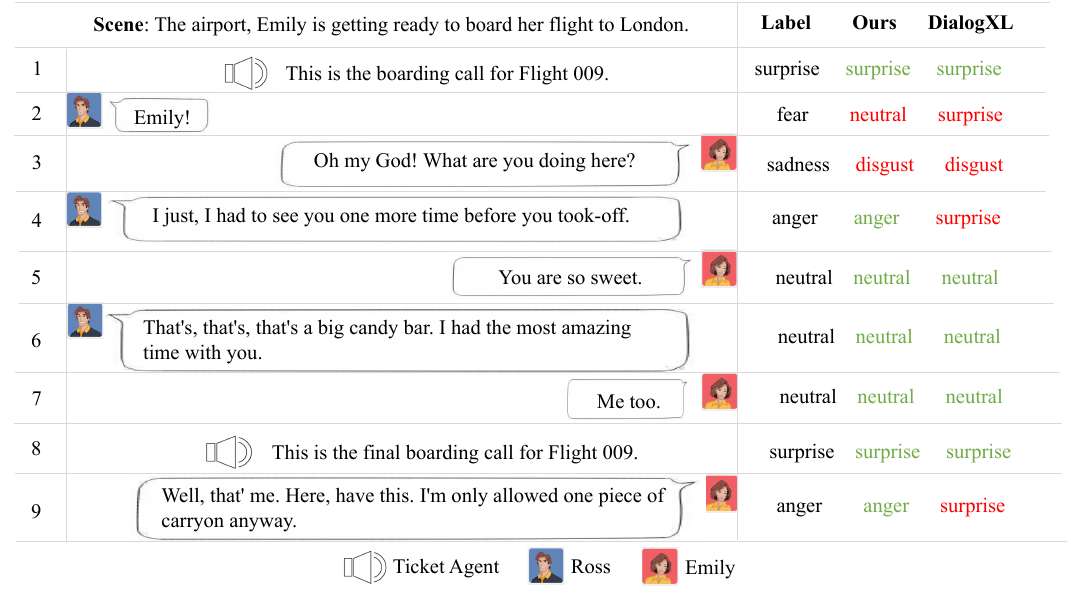
Figure 6. Results of the case study on the EmoryNLP dataset, where three participants in a conversa- tion are provided, along with their dependent historical utterances. We use green and red to highlight the right and wrong